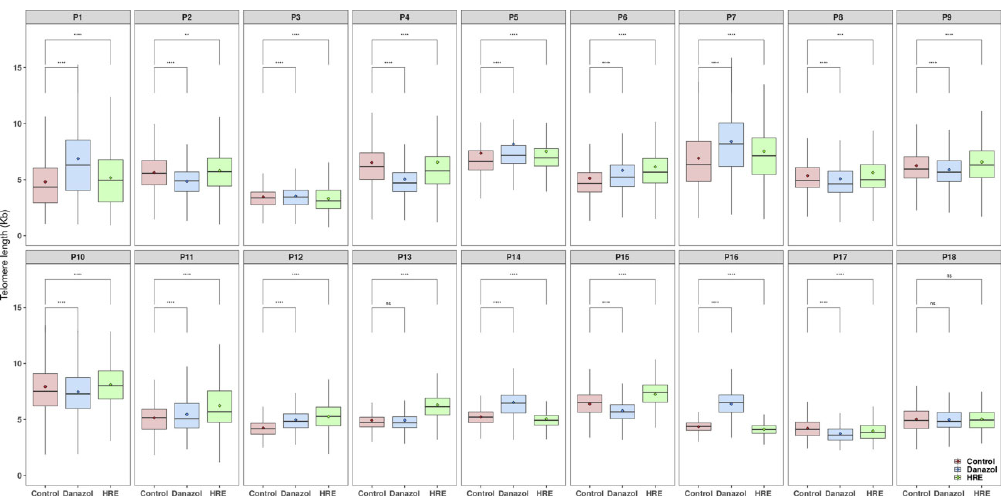
Figure 5. Box plots of telomere length in circulating lymphocytes from healthy donors determined by Q ‐ FISH. Mean values are shown by diamond ‐ shaped points. The middle line reflects the median, the box length reflects the interquartile range (interquartile range, 75th–25th percentiles) and the whiskers reflect the 5th and 95th percentiles. Statistical significance of the difference between telomere length of circulating lymphocytes before and after treatment with HRE and danazol (1 μ g/mL) (one ‐ way analysis of means ANOVA): **** p < 0.0001. NS: not significant.